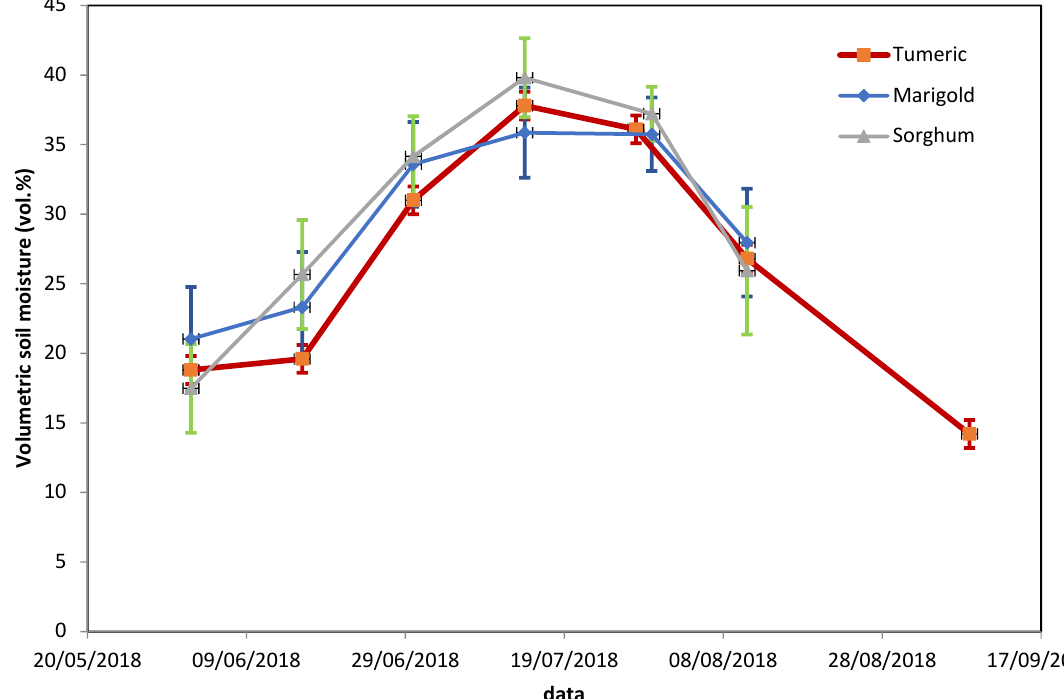
Figure 3. In situ soil moisture measurements in reference fields during the ground campaigns.